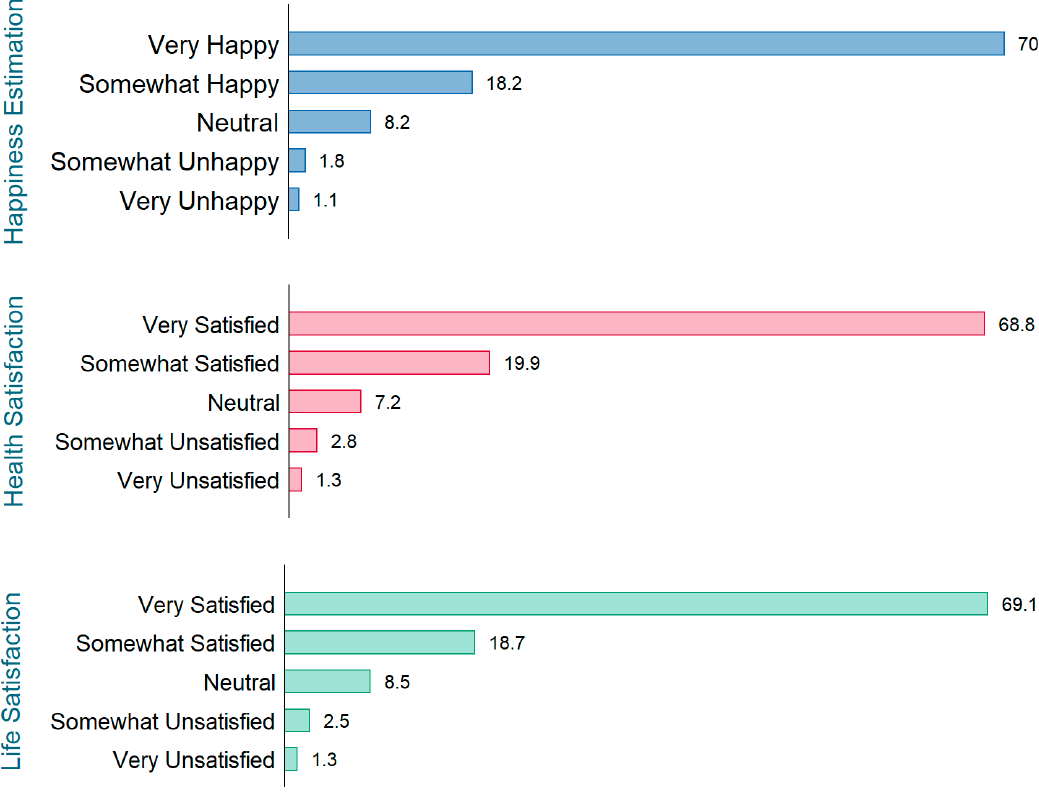
Figure 1. Proportion of self-reported happiness, health, and life satisfaction.